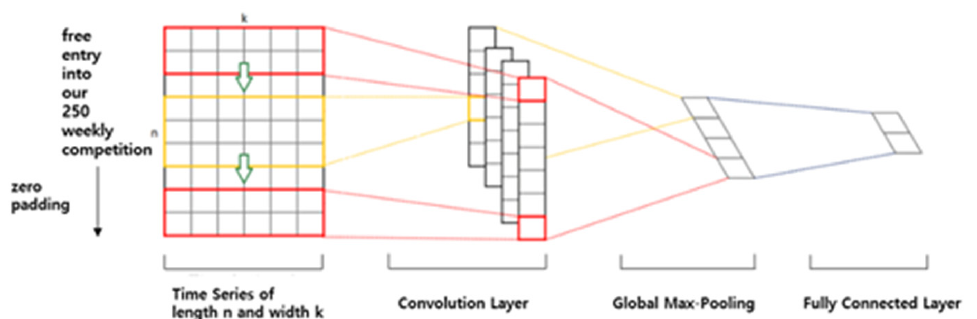
Figure 3. Text‑based CNN 1D Figure 3. Text-based CNN 1D preprocessing. Table 5. Settings of CNN 1D model.